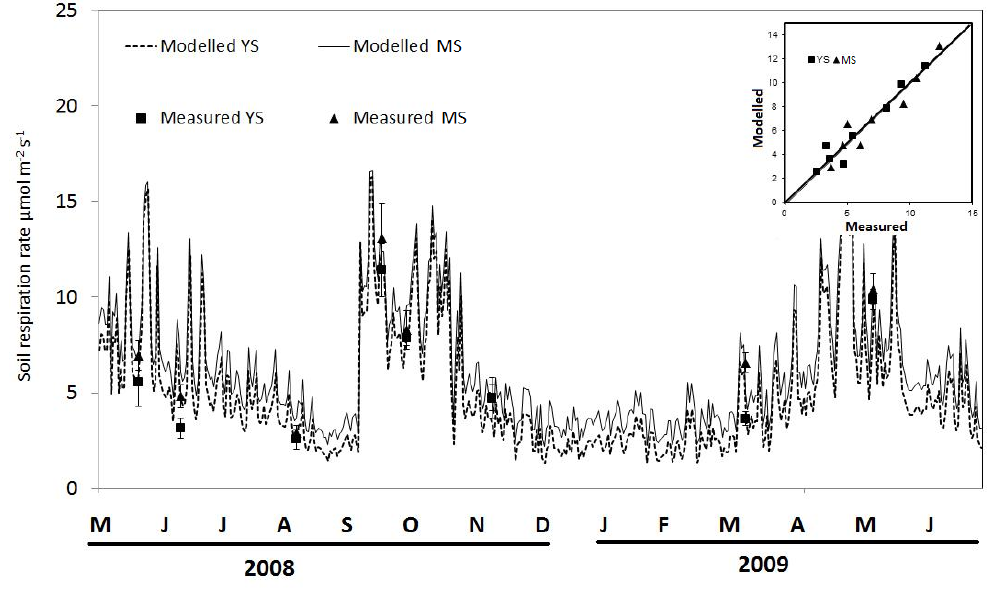
Figure 6. Seasonal variations of modelled (YS: dotted line, MS: solid line) and observed (YS: filled square, MS: filled triangle) soil respiration rate (R s ). Error bars are standard errors of the mean. Measured against modelled soil respiration in the young stand (YS: thin line) and the aged stand (MS: tick line), using Expo model are presented in the top right window. The dashed line represents the 1:1 line.